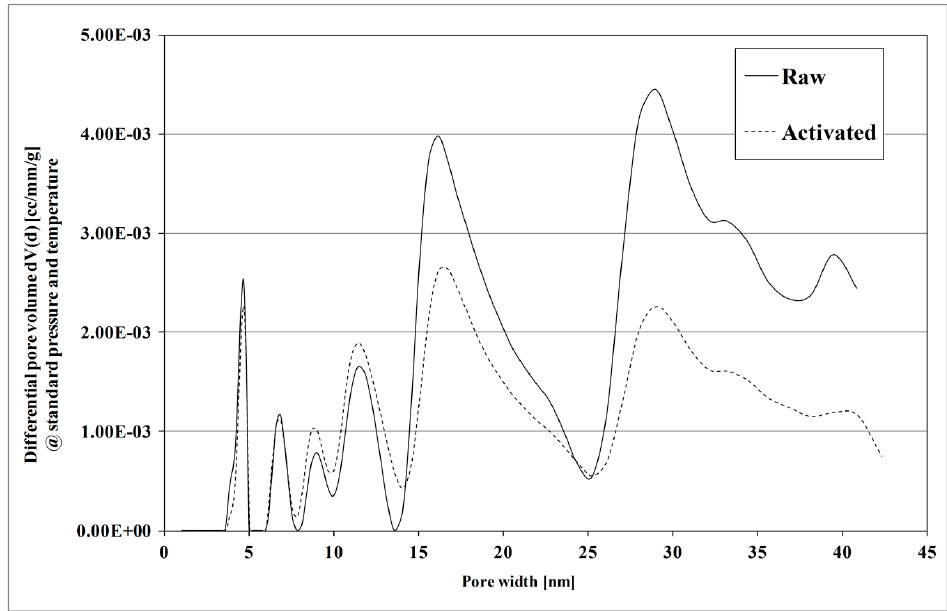
Figure 3. Pore size distribution curves obtained from quench solid density functional theory (QSDFT) analysis.